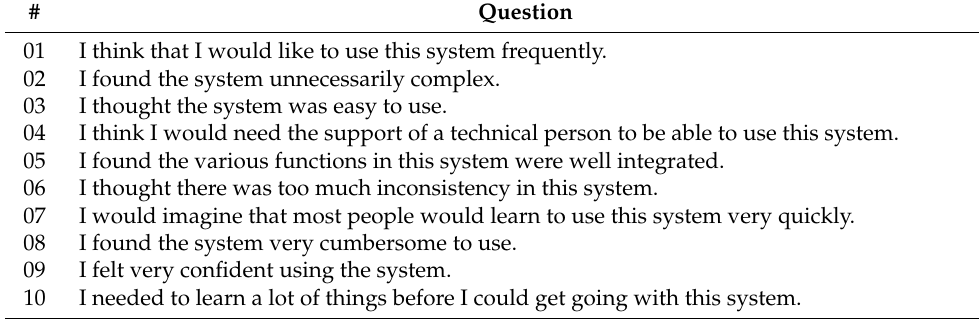
Table 4. System Usability Scale